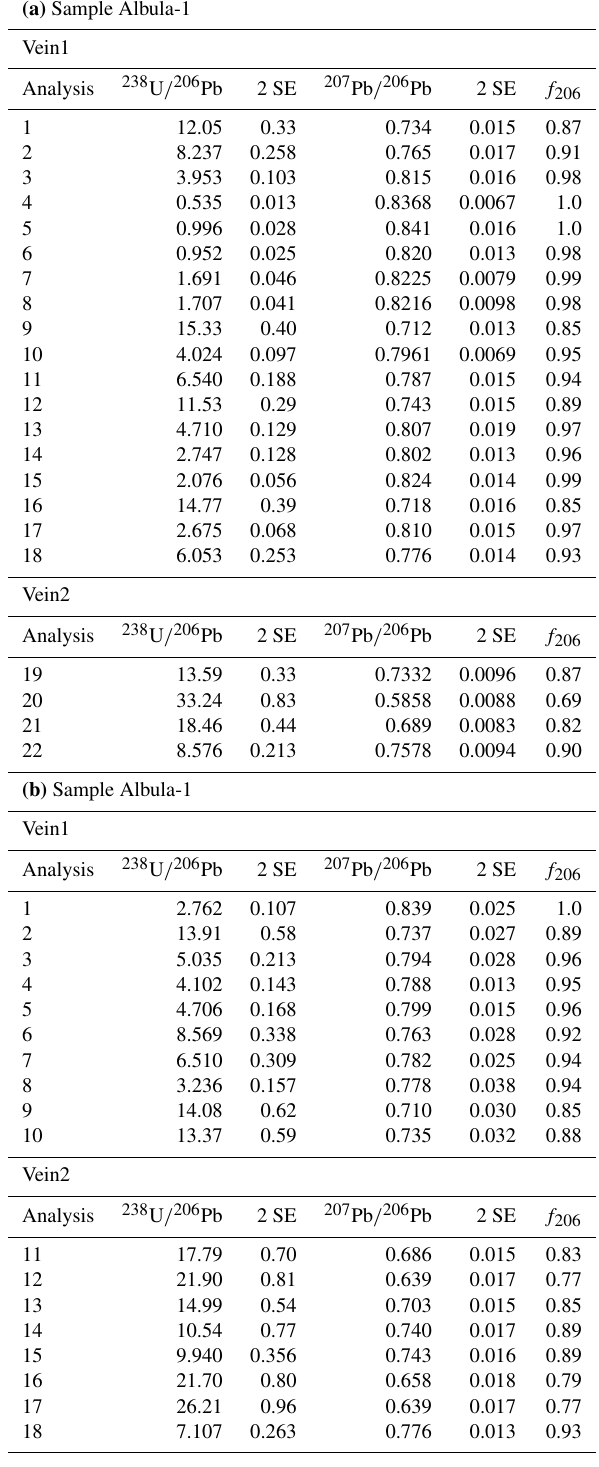
Table 5. 238 U / 206 Pb and 207 Pb / 206 Pb ratios and their uncertain- ties as 2 standard errors (2 SE) measured by LA-ICP-MS. f 206 is calculated using the initial 207 Pb / 206 Pb indicated by the